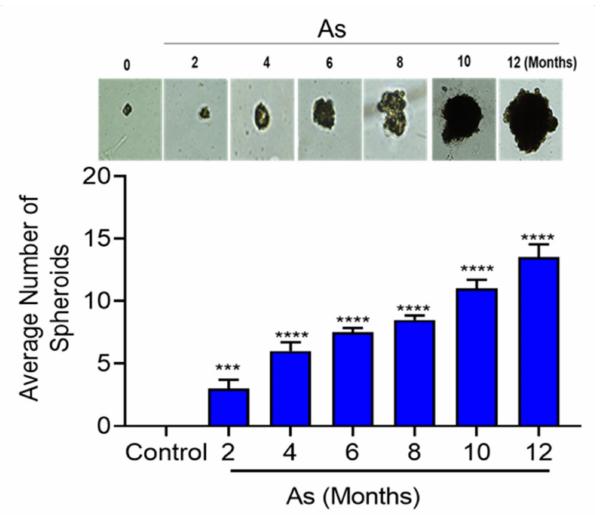
Figure 6. Sphere formation ability of transforming TRT-HU1 cells (0, 2, 4, 6, 8, 10, and 12 months). Control and transforming (2 × 10 3 cells) were plated in 12-well ultra-low attachment plates, and allowed for 14 days, then the total number of spheres per well were counted. The horizontal bars represent the mean number of spheres, *** p < 0.001, and **** p <